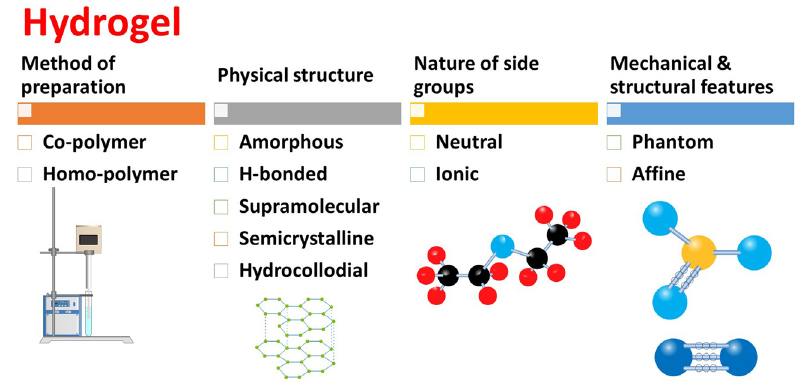
Figure 6: Classi fi cation of hydrogels based on their